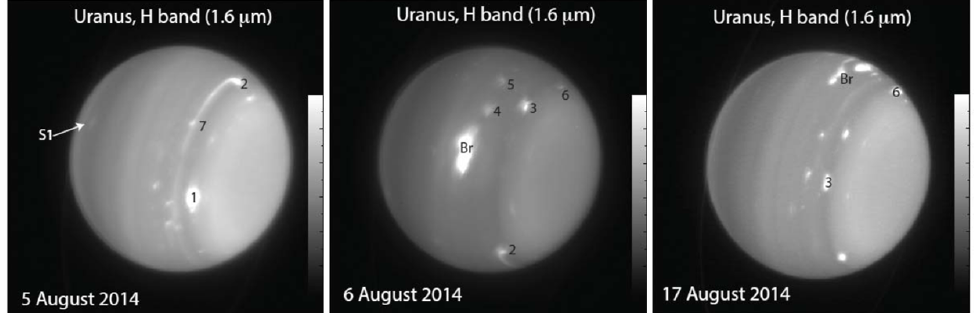
Figure 7. Observations of discrete cloud structures on Uranus in the infrared wavelength from the Keck observatory. ‘Br’ corresponds to the Berg structure, but several other regions show cloud structures (numbered). Adapted from